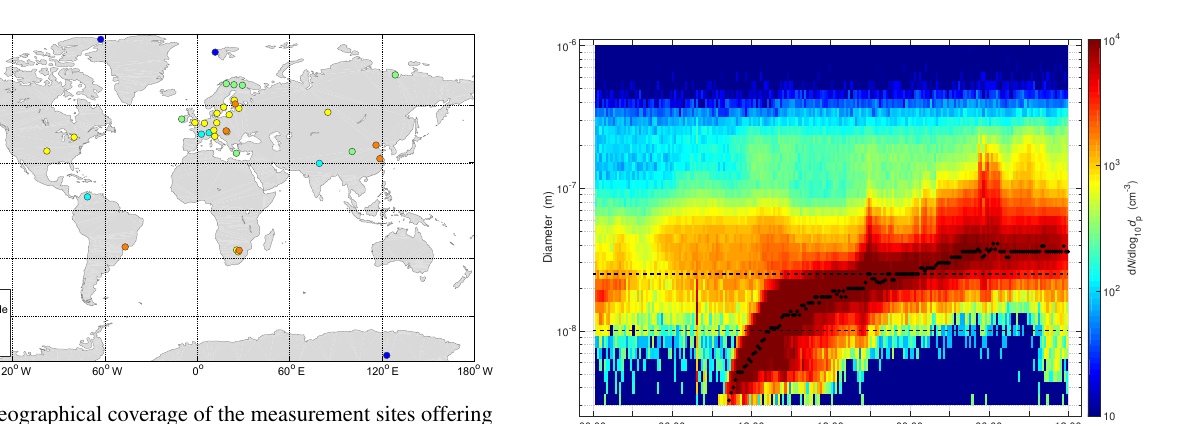
Figure 1. Geographical coverage of the measurement sites offering long-term (at least 1 full year) aerosol number size distribution in the submicron size range. The color of the points refers to the group- ing of the sites in Table 1 according to their environment type.